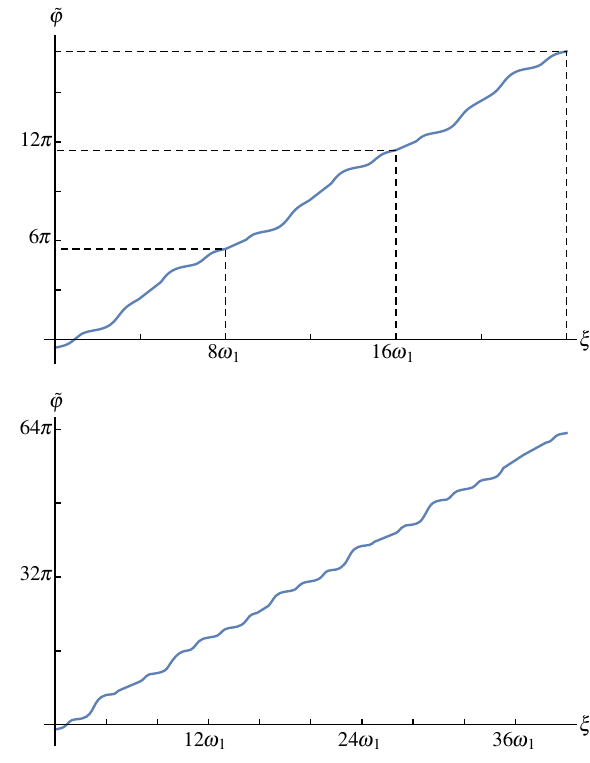
Fig. 8 The velocity of the periodic disturbances as function of ˜ a for translationallyinvariantseeds(top)andstaticseeds(bottom)forvarious valuesoftheenergyconstant E .Thesecurvesareasmoothcontinuation of the curves of Fig. 5 with the same color